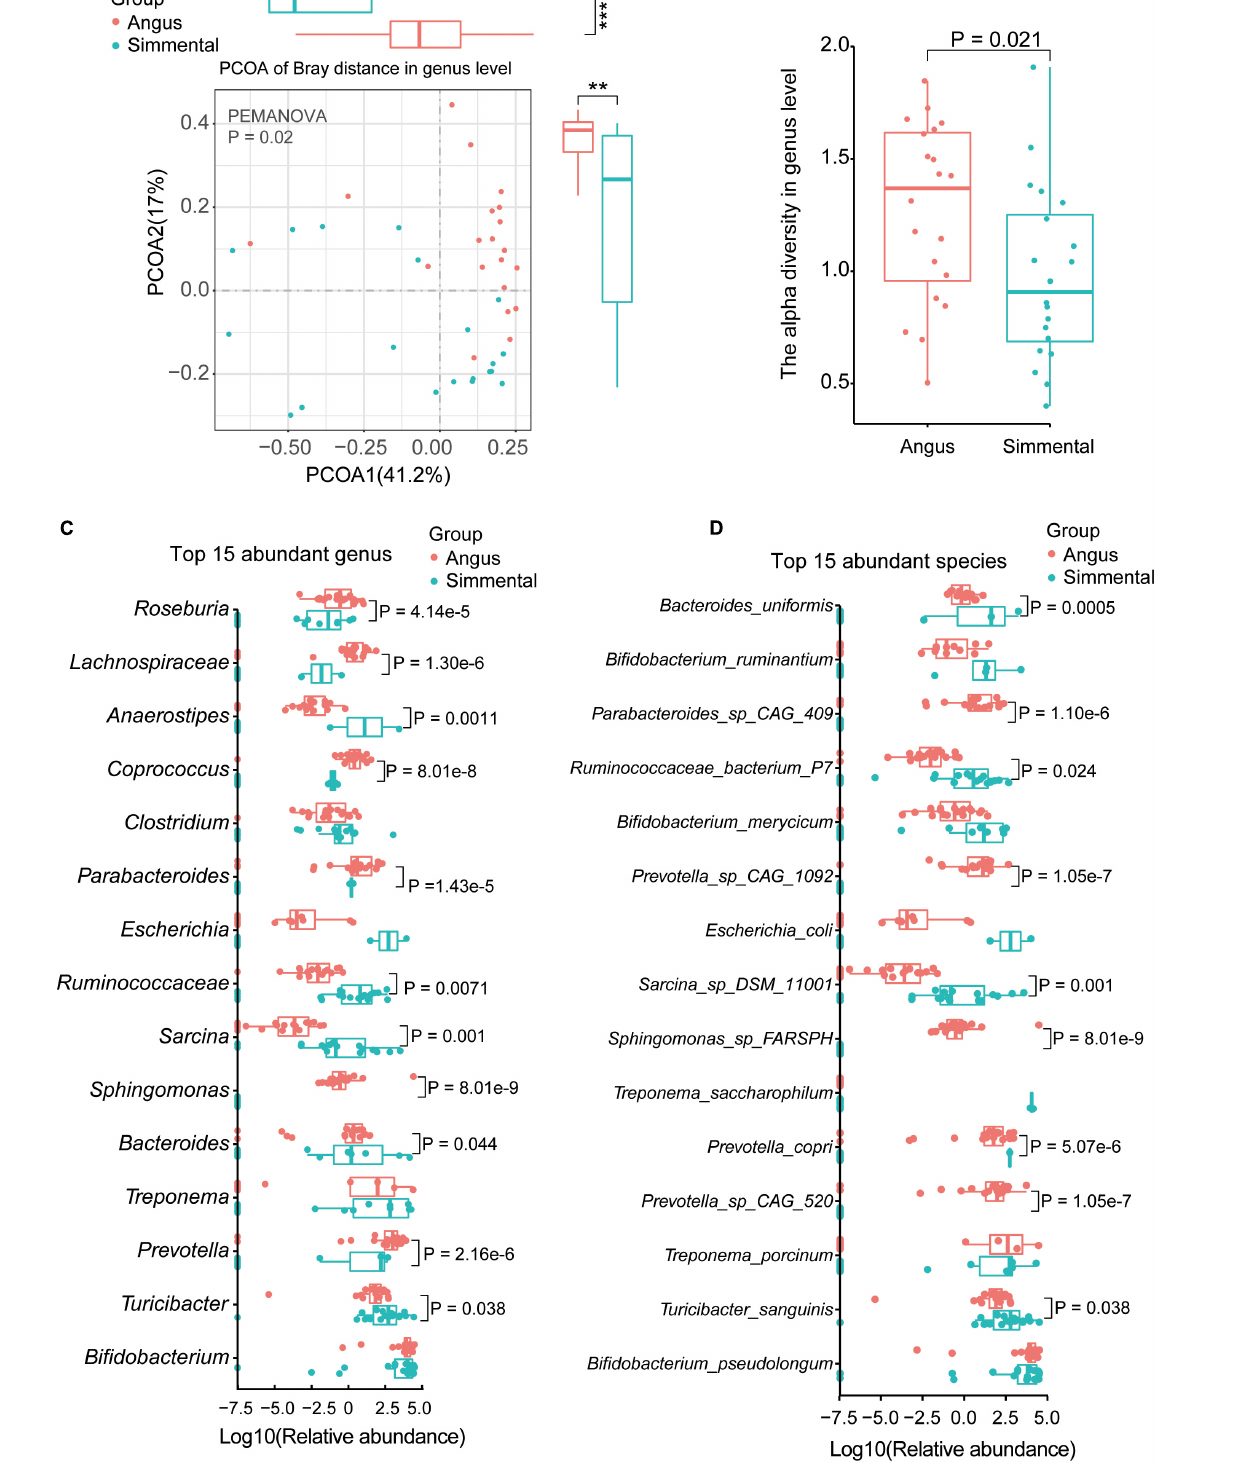
FIGURE 1 | Taxonomic analysis of the gut microbiota for the Chinese Simmental and Angus cattle. The Angus cattle had higher beta-diversity (A) and alpha-diversity (B) than the Chinese Simmental cattle at genus level. The differences of the top 15 abundant genera (C) and species (D) are shown.